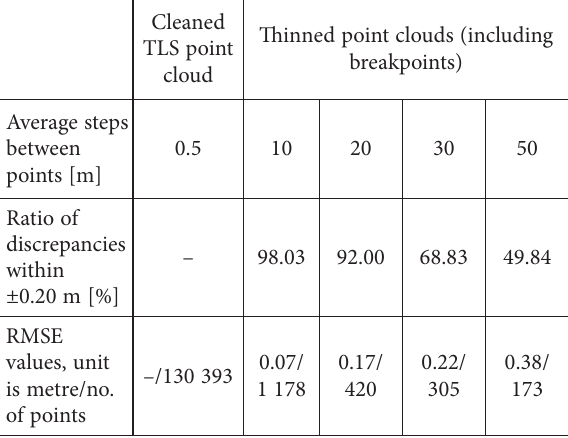
Table 2. The comparison results of surface models